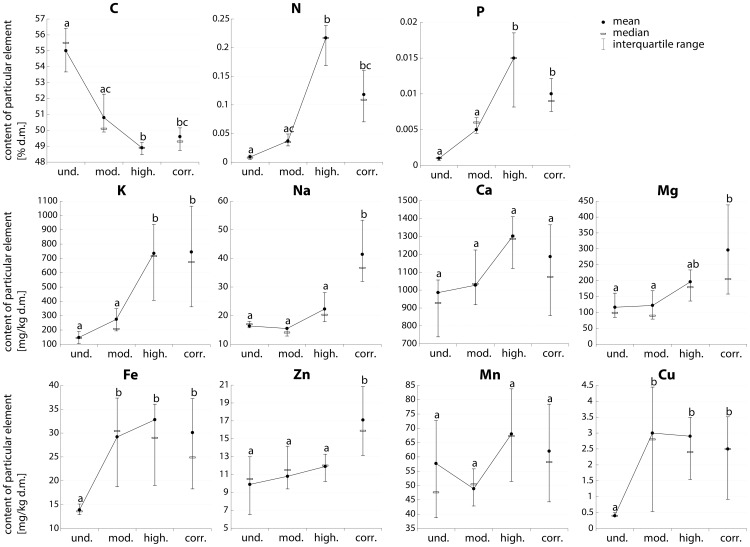
Decay-related changes of elemental content in pine stumps inhabited by larvae. und. - undecayed wood; mod. - moderately decayed wood; high. - highly decayed wood; corr. - corridors (see text for definitions of wood decay categories).Values bearing the same letter do not differ significantly between wood decay categories (Kruskal-Wallis test, p<0.05). For detailed results, see S1 Table.